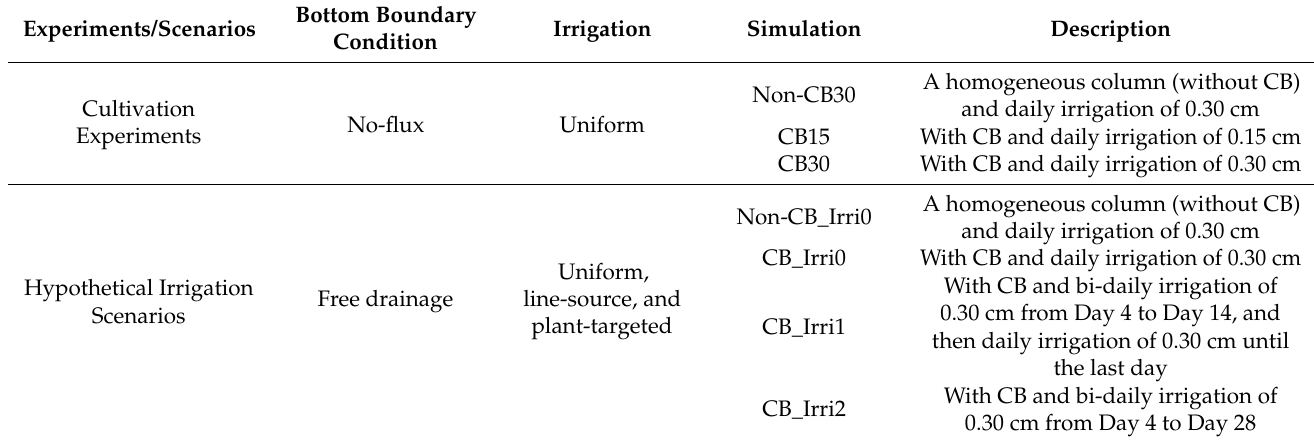
Table 4. Summary of all simulation